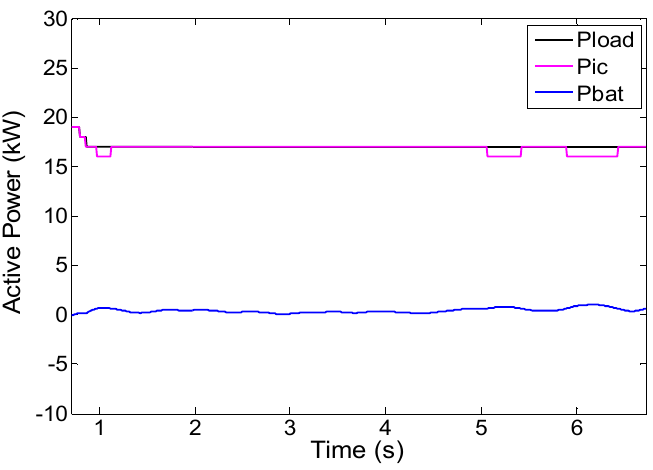
Figure 22. DC active power flow in the second case.